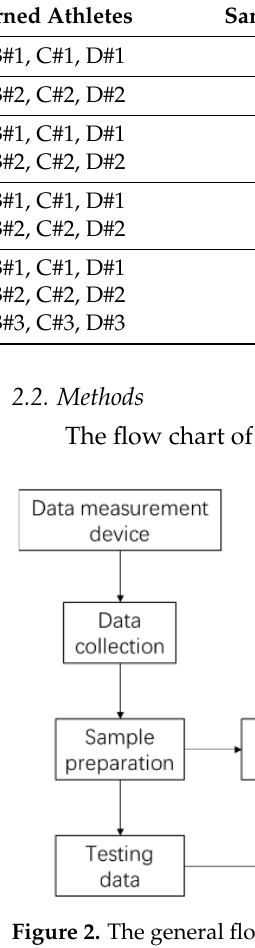
Table 1. Information for the athlete movement pressure measurement dataset used in this paper.